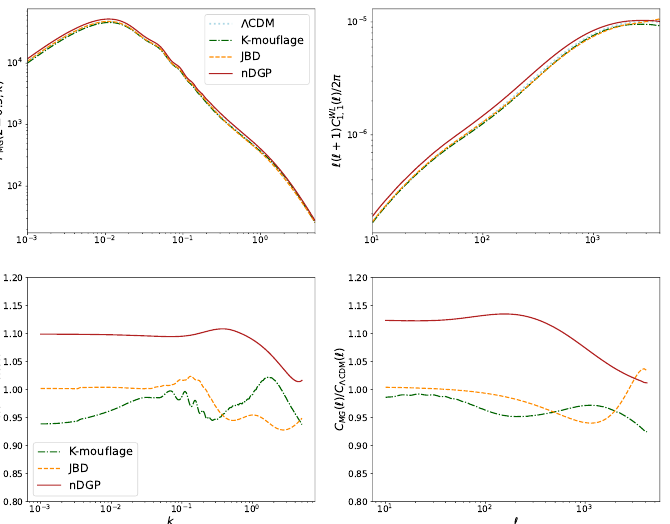
Figure 10. ( Upper left ): Matter power spectrum P ( k , z ) for Λ CDM (in light blue), K-mouflage (in green), JBD (in orange) and nDGP (in red) computed with privately modified versions of MGCAMB , hi_class and EFTCAMB . ( Lower left ): Ratio of Λ CDM for the matter power spectra for the three cosmological models considered above. While at linear scales k (cid:46) 0.07h/Mpc, the models considered show only a slight change in amplitude compared to Λ CDM, at smaller scales there are some distinctive features, such as shifts in the BAO peaks and damping of power at small scales. ( Upper right ): Angular cosmic shear (weak lensing) power spectra for the 1,1 bin (lower redshifts) defined in (181) for the models mentioned above. ( Lower right ): Ratio of the weak lensing C (cid:96) for screened modified gravity with respect to Λ CDM. The distinctive features observed in the matter power spectrum are smoothed out by the projection along the line of sight and into angular